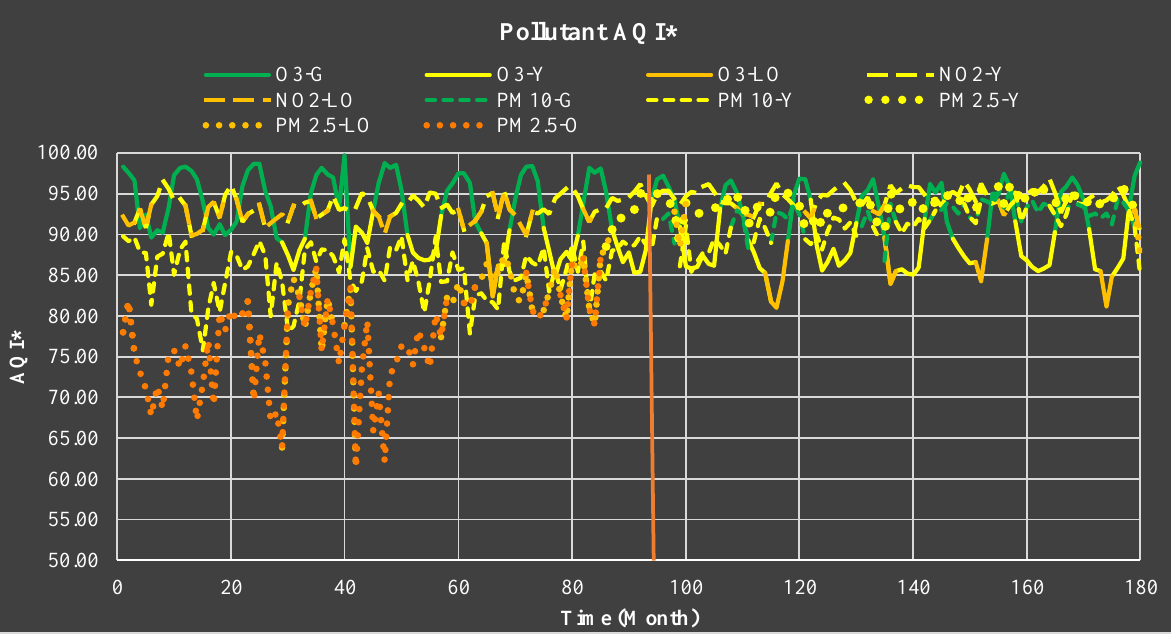
Figure 8. Individual AQI* functions for air pollutants. Data series: Barcelona 2001-2015. Red line stands for